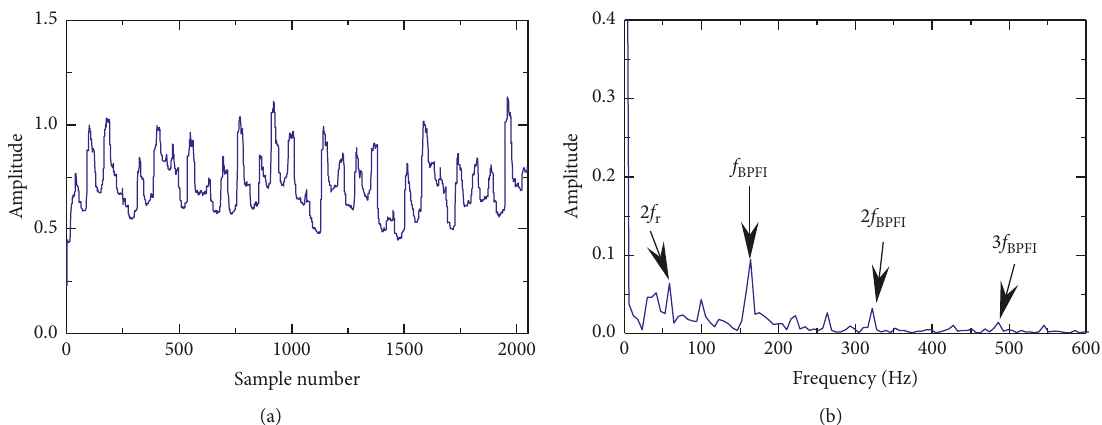
Figure 15: Case 1: waveform and spectrum of the traditional MMF filtering result: (a) time-domain waveform; (b) amplitude spectrum.